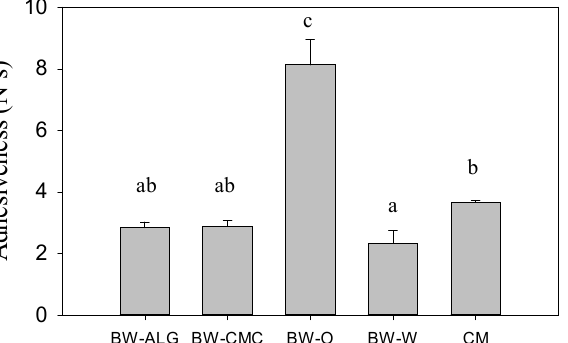
Figure 2. Firmness, spreadability, and adhesiveness of bigels (BW-ALG and BW-CMC), oleogel (BW- O), emulsion of BW-O with water (BW-W), and commercial margarine (CM). Means with different superscript letters in columns are significantly different ( p ≤ 0.05) for one-way ANOVA and Tukey’s test.